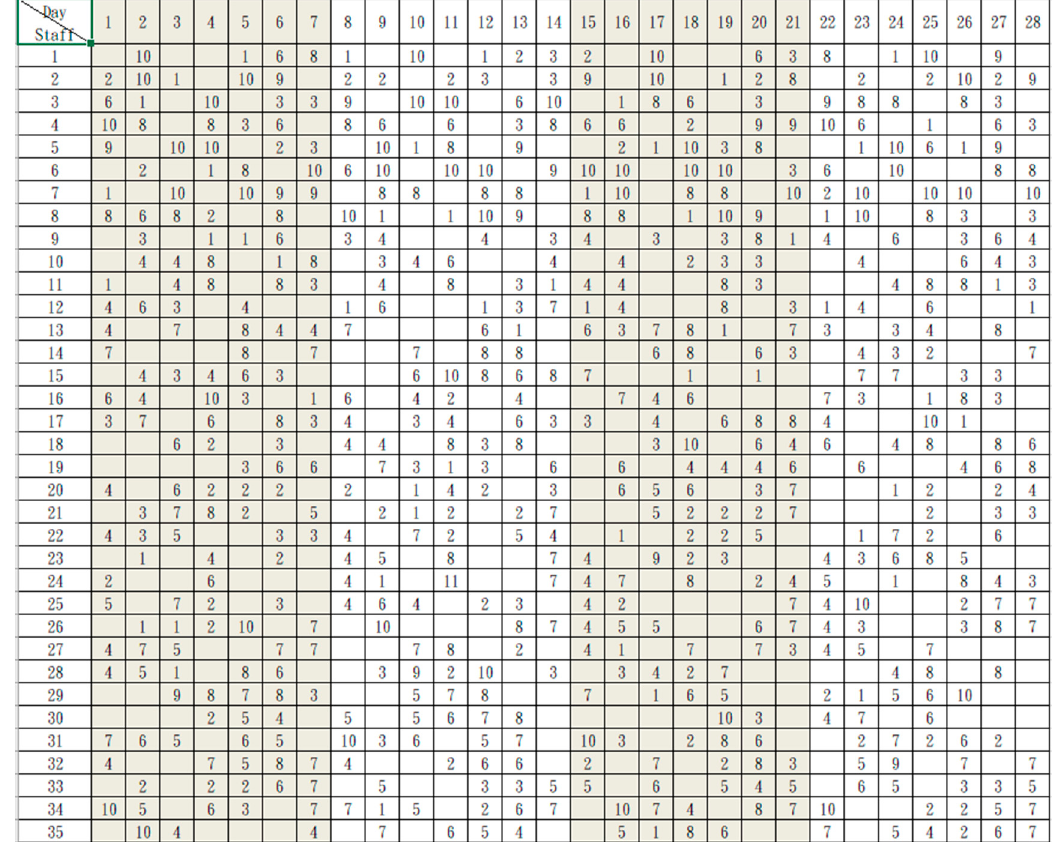
Figure 4. Monthly schedule output.